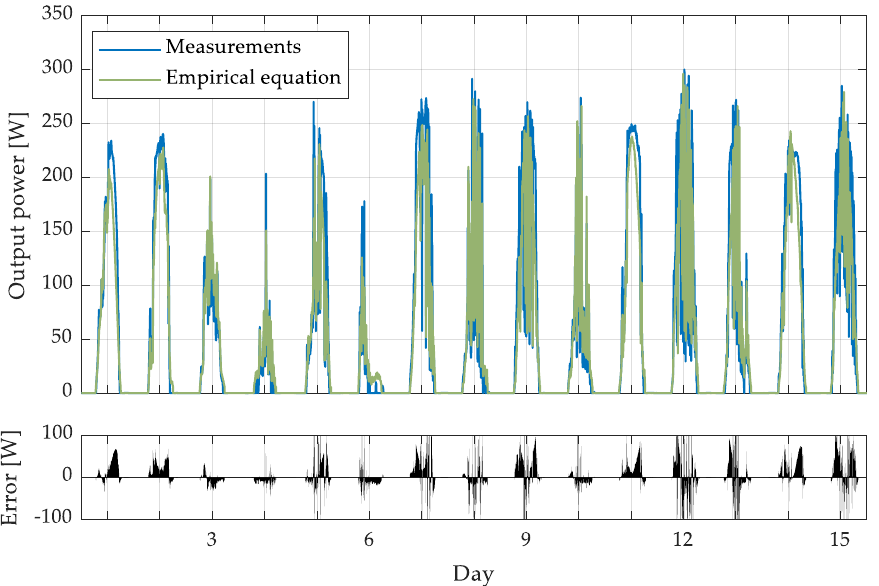
Figure 7. Validation of the static electric model (Matlab/Simulink-empirical equation) with experi- mental data (for 15 days in March 2021).